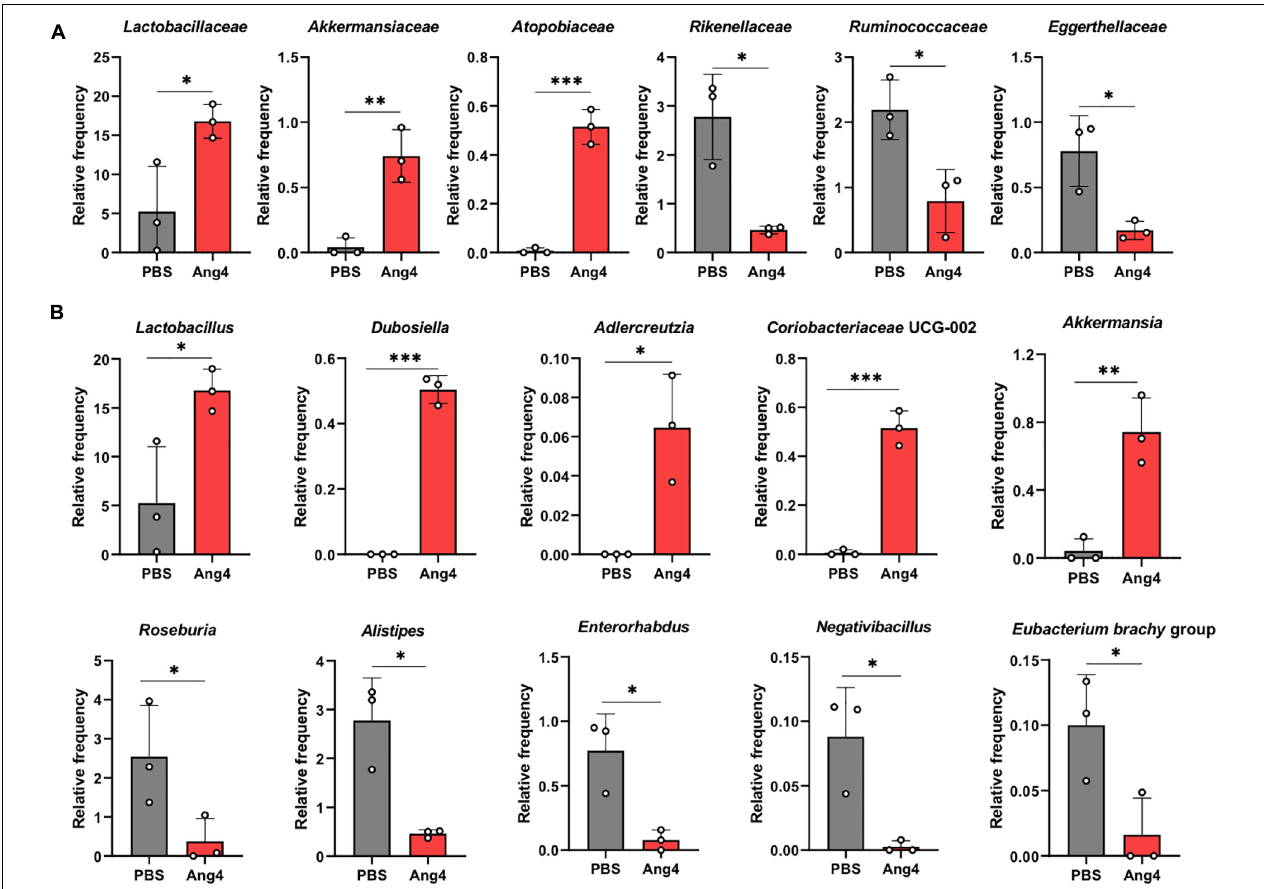
FIGURE 7 | Administration of Ang4 alters composition of gut microbiota. (A) Relative abundance of bacteria at the family level. (B) Relative abundance of the genera. All figures represent the fecal bacteria that were significantly altered between Ang4- and PBS-treated mice. P -values were determined by two-tailed unpaired t